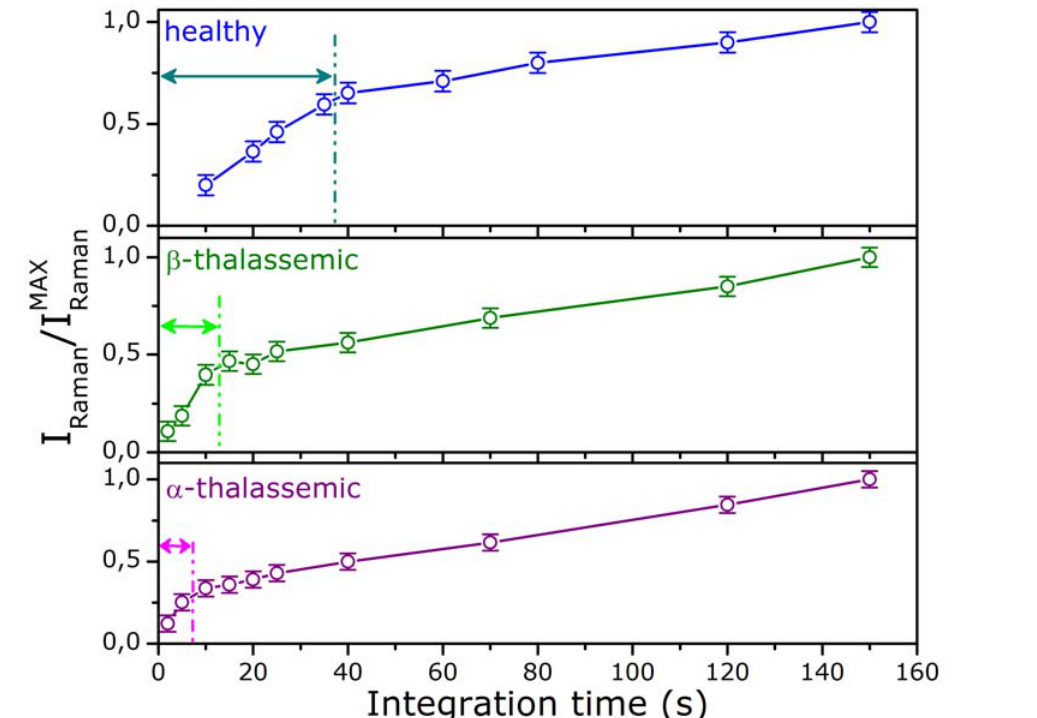
Figure 5. Intensity of the  Raman peak, as function of the integration time, with  continuous exposure to 532 nm radiation, for normal, β - and α -thalassemic